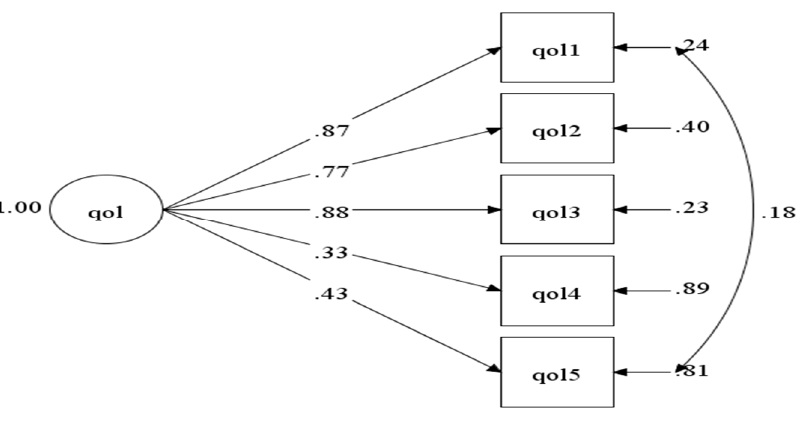
Figure 2. Model of quality of life domain in BLQoL-M.